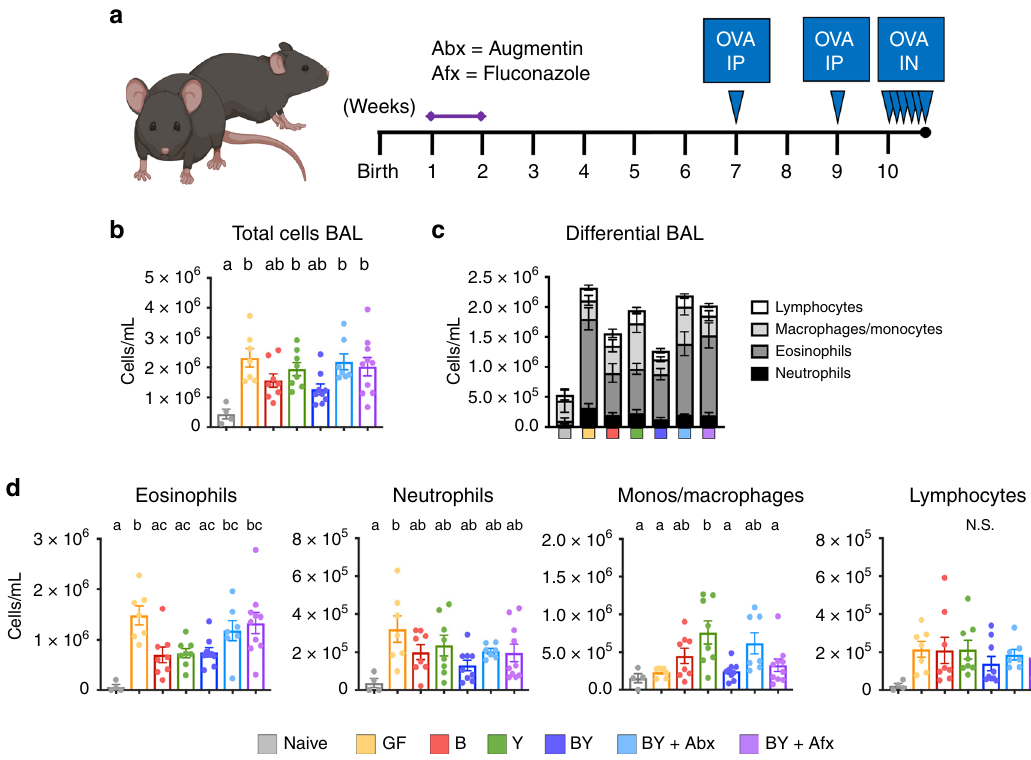
Fig. 6 Fungal colonization modulates OVA-induced airway in fl ammation phenotype. a Experimental layout for OVA-induced airway in fl ammation. Two groups of BY animals were additionally treated with antimicrobials Augmentin (Abx) or Fluconazole (Afx) during the second week of life. F1 mice were systemically sensitized with two intraperitoneal (IP) injections of OVA + Alum at weeks 7 and 9. Afterward, F1 mice were challenged intranasally (IN) with OVA, for 5 consecutive days at week 10. A group of mice were kept unchallenged and denoted naive (see Methods). b Total cellular count in BAL fl uid following OVA challenge. c Compiled differential counts of cellular in fi ltrate in gnotobiotic groups. d Differential leukocyte counts in challenged mice. b – d Data expressed as mean ± S.E.M.; color denotes colonization and OVA challenge (Naive = gray, GF = yellow, B = red, Y = green, BY = royal blue, BY + Abx = cyan blue, BY + Afx = purple); N NAIVE = 5, N GF = 7, N B = 8, N Y = 8, N BY = 9, N Abx = 7, N Afx = 10; b , d different letters above bars